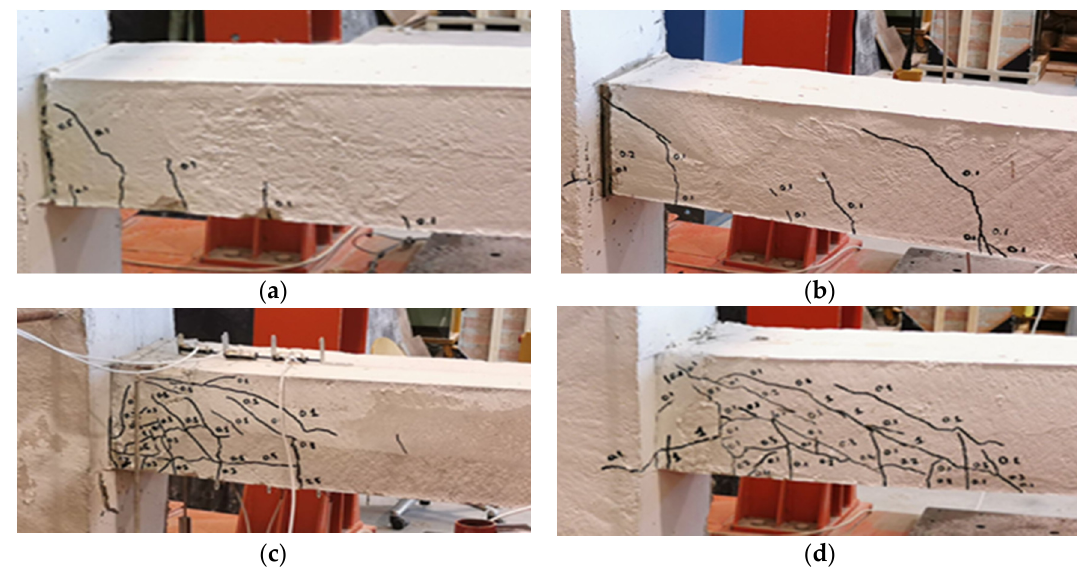
Figure 6. Failure patterns of specimens under monotonic loading: ( a ) M1.6 Φ 10 Ν L; ( b ) M3.1 Φ 14 Ν L; ( c ) M1.6 Φ 10L35; ( d ) M3.1 Φ 14L35.